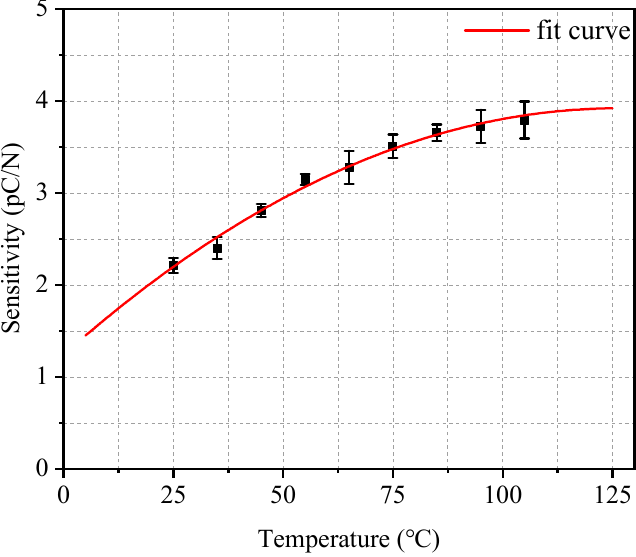
Figure 7. Schematic diagram of the aluminum heating plate.